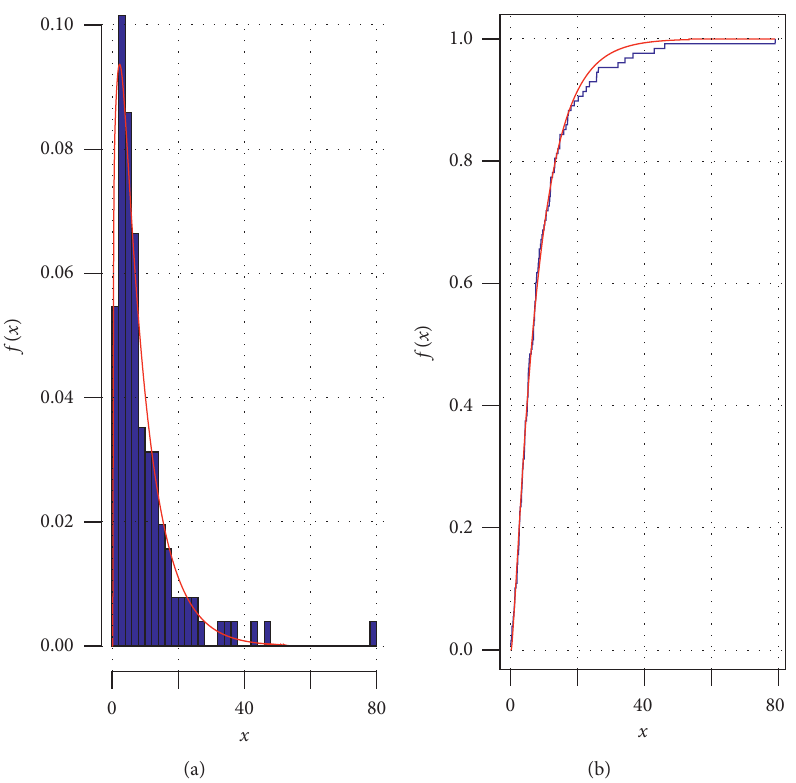
Figure 7: The EPDF (a) and the EHRF (b) for bladder cancer